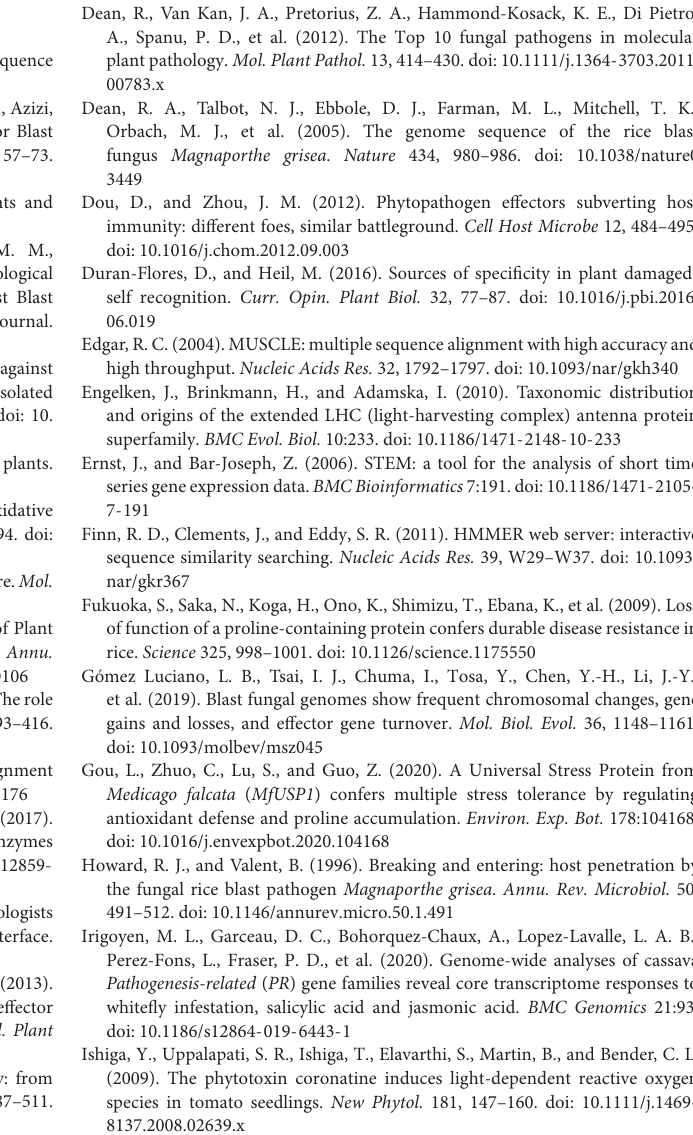
Supplementary Figure 4 | Analysis of O. sativa CDEGs associated with secondary metabolites biosynthesis. (A) Distribution of CDEGs in different secondary metabolites biosynthesis clusters predicted by antiSMASH. (B) Two terpene biosynthesis clusters include CDEGs involved in terpene biosynthesis. (C) Visualization based on KEGG pathway annotation of terpene synthase relates to CDEGs. Supplementary Figure 5 | Alternative splicing analysis of one RCD1-SRO-TAF4 (RST) protein (LOC_Os10g42710). (A) The expression value of seven transcripts of LOC_Os10g42710 at control sample and 8 hpi. (B) Structure and Sashimi plot of LOC_Os10g42710.1 and LOC_Os10g42710.2 transcripts. The plot of domain coordinate was displayed above the transcript structure plot. Supplementary Figure 6 | Analysis of M. oryzae Carbohydrate-Active enzyme (CAZyme) relates to pathogenicity. (A) The proportion of each CAZyme subfamilies. (B) The count of secreted proteins is assigned to the CAZyme subfamily of AA9, GH10, GH3, CE5, and GH7. (C) The expression level of MoCDIP4 and its seven homologous genes coding proteins with a signal peptide and AA9 CAZy